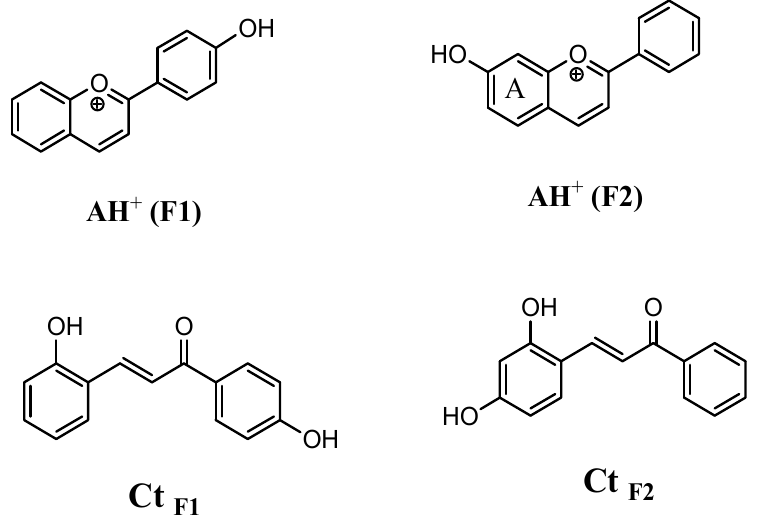
Figure 2. Structure of flavylium ( AH + ) isomers 4 ′ -hydroxyflavylium ( F1 ) and 7-hydroxyflavylium ( F2 ) and their corresponding trans -chalcone isomers Ct F1 (3-(2-hydroxy-phenyl)-1-(4-hydroxy-phenyl)-propenone) and Ct F2 (3-(2,4-Dihydroxy-phenyl)-1-phenyl-propenone) in the equilibrated mixture at different pH levels.